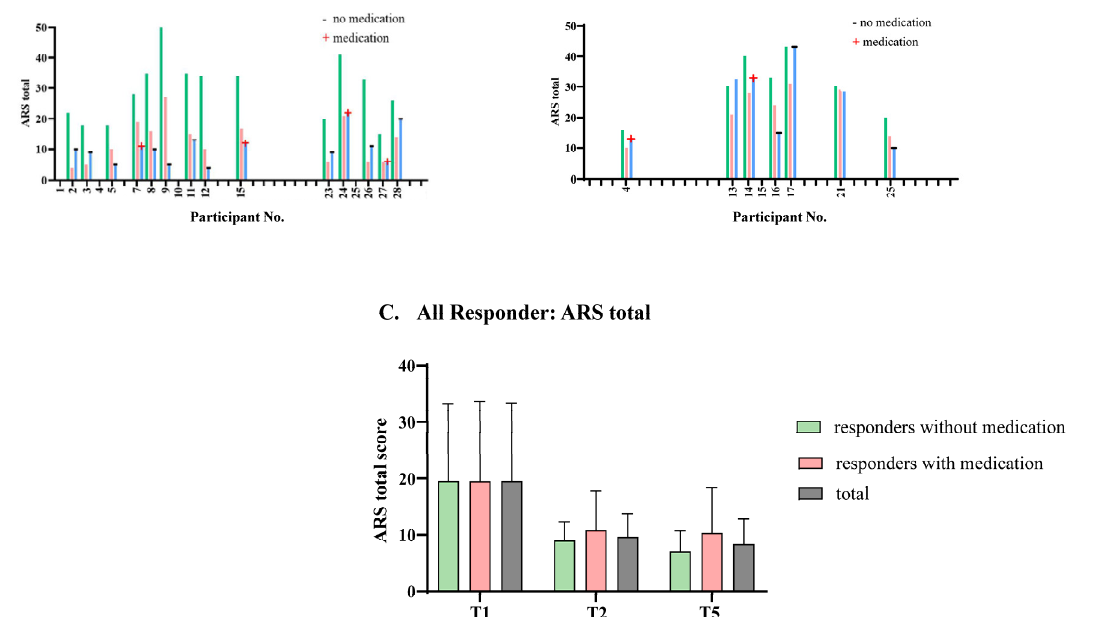
Figure 3. ( A ) Course of the ARS scores over time from the responders. Green = before the diet, red = after the diet, blue = follow–up. ( B ) Course of the ARS scores over time from the non-responders. Green = before the diet, red = after the diet, blue = follow–up; ( C ) means and standard deviations of all